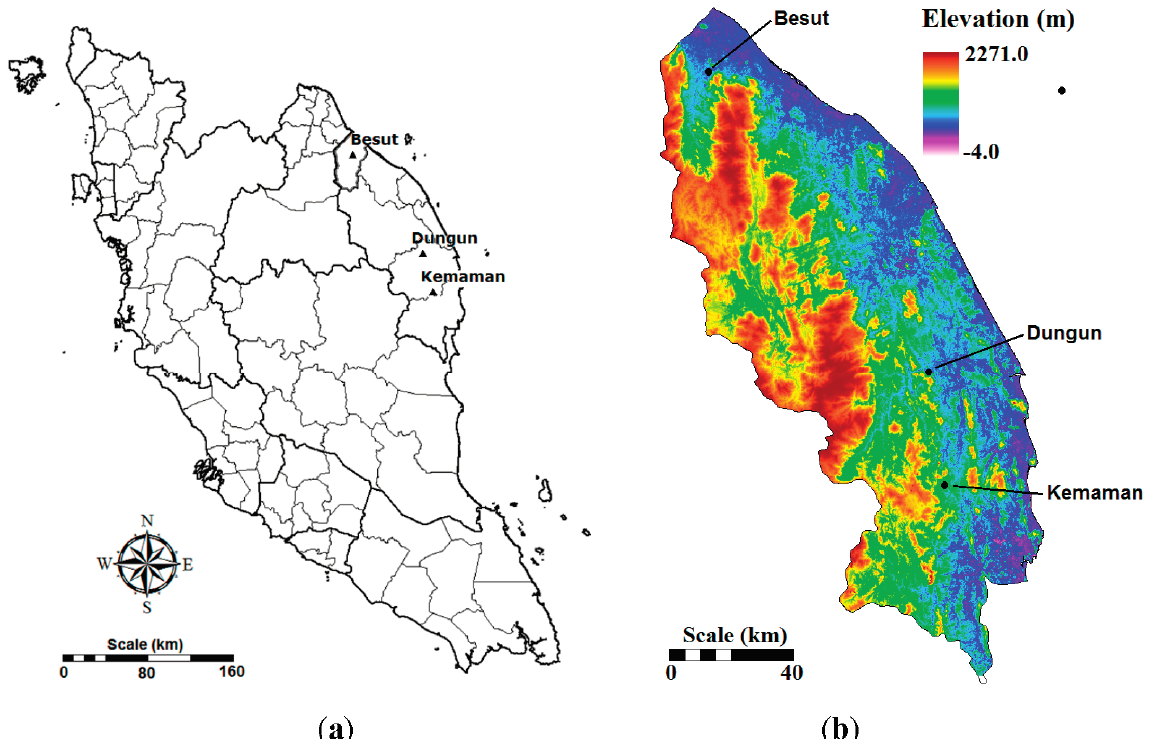
Figure 1. ( a ) Location of the rain gauge stations in Peninsular Malaysia; ( b ) terrain map of the study area.